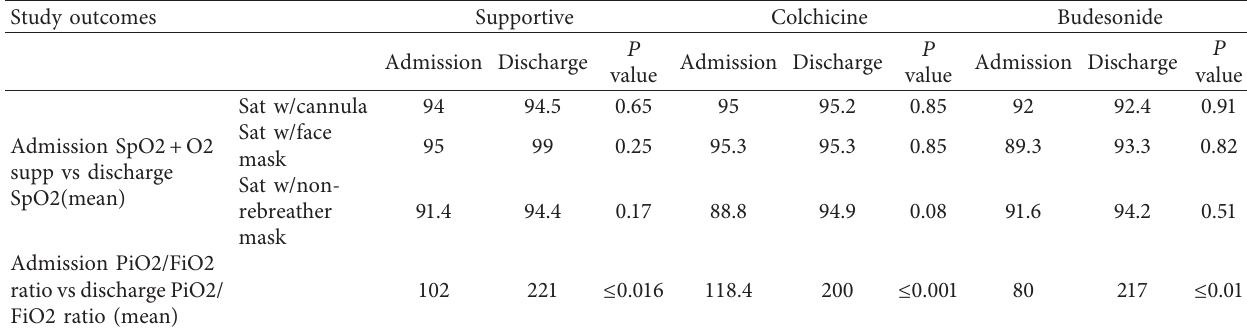
Table 3: Oxygen saturation and PaO2/FiO2 ratio between admission and